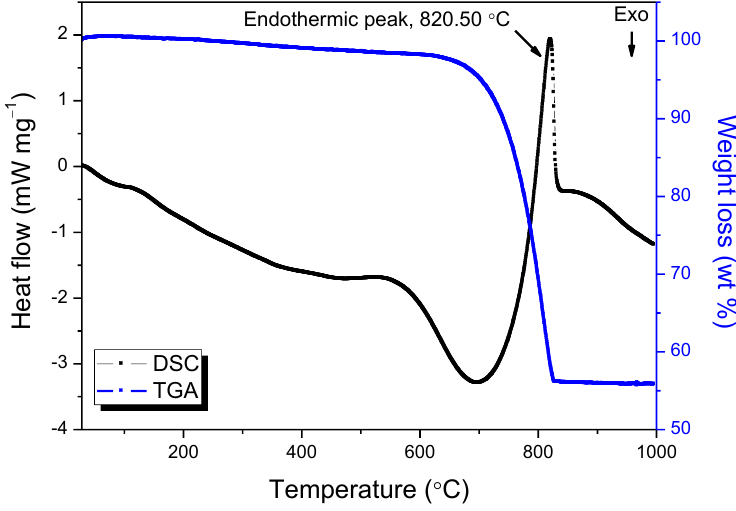
Figure 16. STA (TGA/DSC) measurement of OSP (sample mass 11.151 mg) in Alumina crucibles at a heating rate of 10 K min −1 in argon atmosphere (50 mL min −1 ). Table 6. DSC thermogram data of OSP, neat asphalt, and OSP/asphalt blends containing 5, 10, and 15 wt % OSP loading at heating rate of 20 °C min −1 .